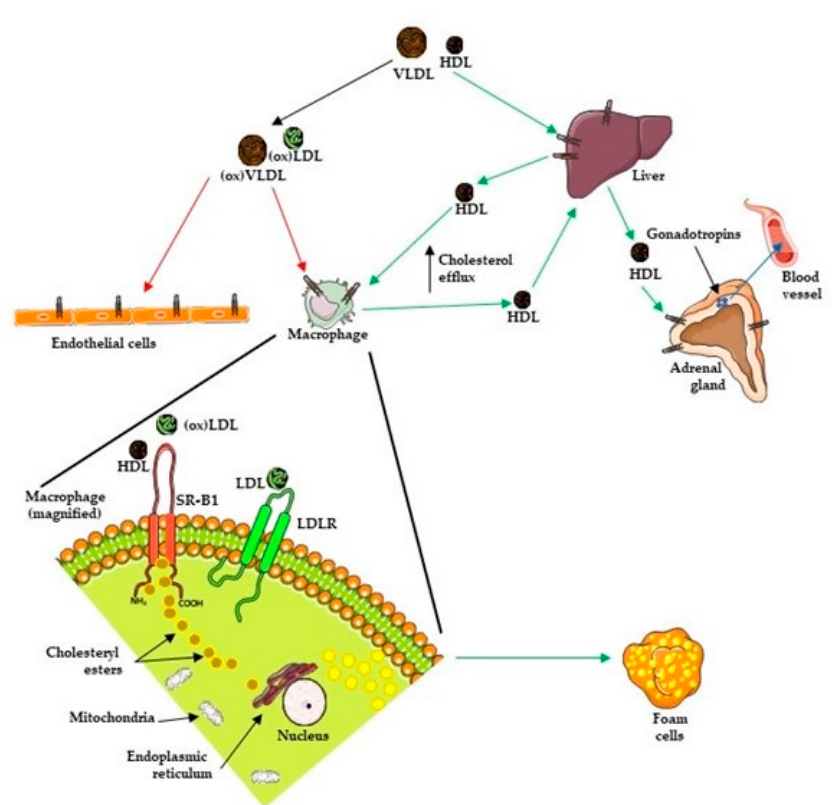
Figure 4. Role of SR-B1 in the development of foam cells from macrophages. Modified lipoproteins are taken by via SR-B1 present on macrophage. Increased uptake of these modified lipoproteins and cholesterol esters lead to excessive fat in cells, culminating in the formation of foam cells, the main constituents of atherosclerotic lesions. Figure produced using Servier medical art [54].